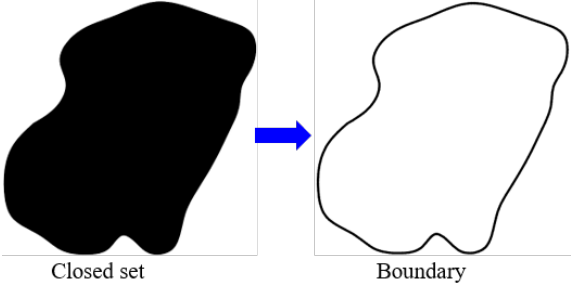
Figure 2. Dimension reduction of grain topologically closed sets.